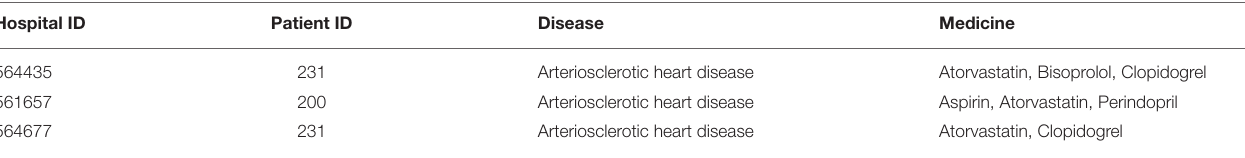
TABLE 1 | Example of case